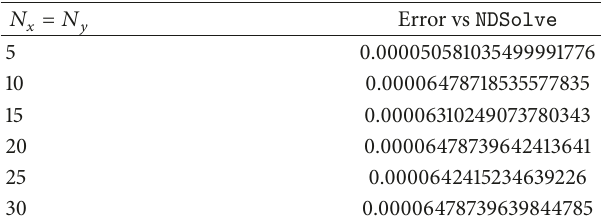
Table 3: Maximum absolute error in the presented method’s solution of the problem described by Example 3 at time 𝑡 = 0.5 .